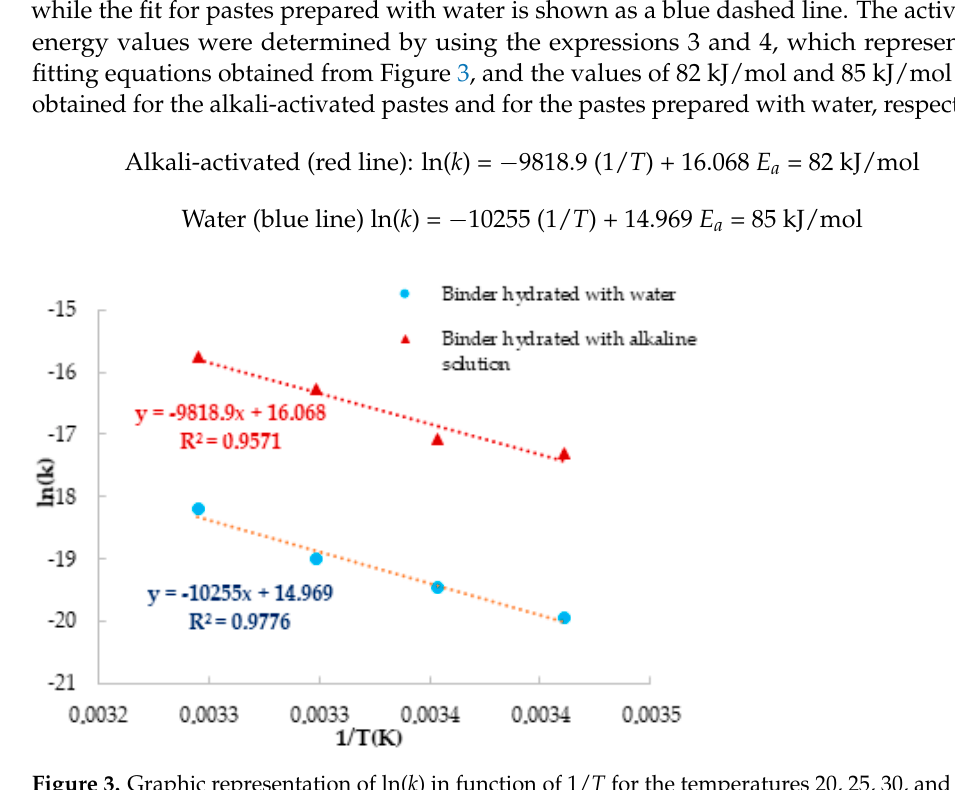
Figure 3. Graphic representation of ln(k) in function of 1/T for the temperatures 20, 25, 30, and 35 °C. The blue dots correspond to the pastes hydrated with water, while the red triangle corresponds to the alkali-activated pastes. The best fit is showed as dashed lines.